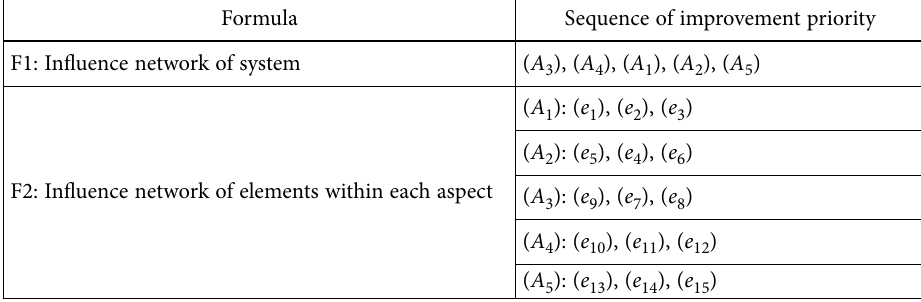
Table 8. Sequence of improvement priority for the approach of sustainability Formula Sequence of improvement